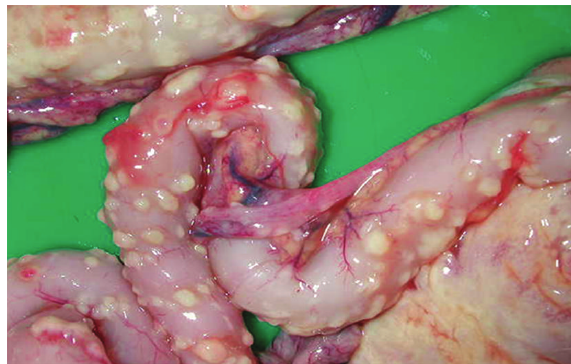
Figure 2: Intestines of a cat with e ff usive FIP. Pyogranulomatous foci are seen as punctate fibrinous plaques on the serosal surface of the